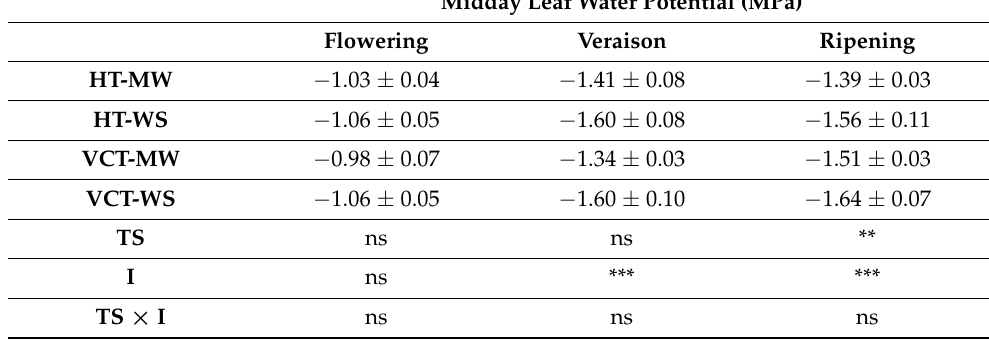
Table 3. Seasonal variation of midday water potential ( Ψ md ) for cv. Maturana Blanca in the head- trained irrigated (HT-MW), head-trained stress (HT-WS), vertical cordon trained irrigated (VCT-MW) and vertical cordon trained stress